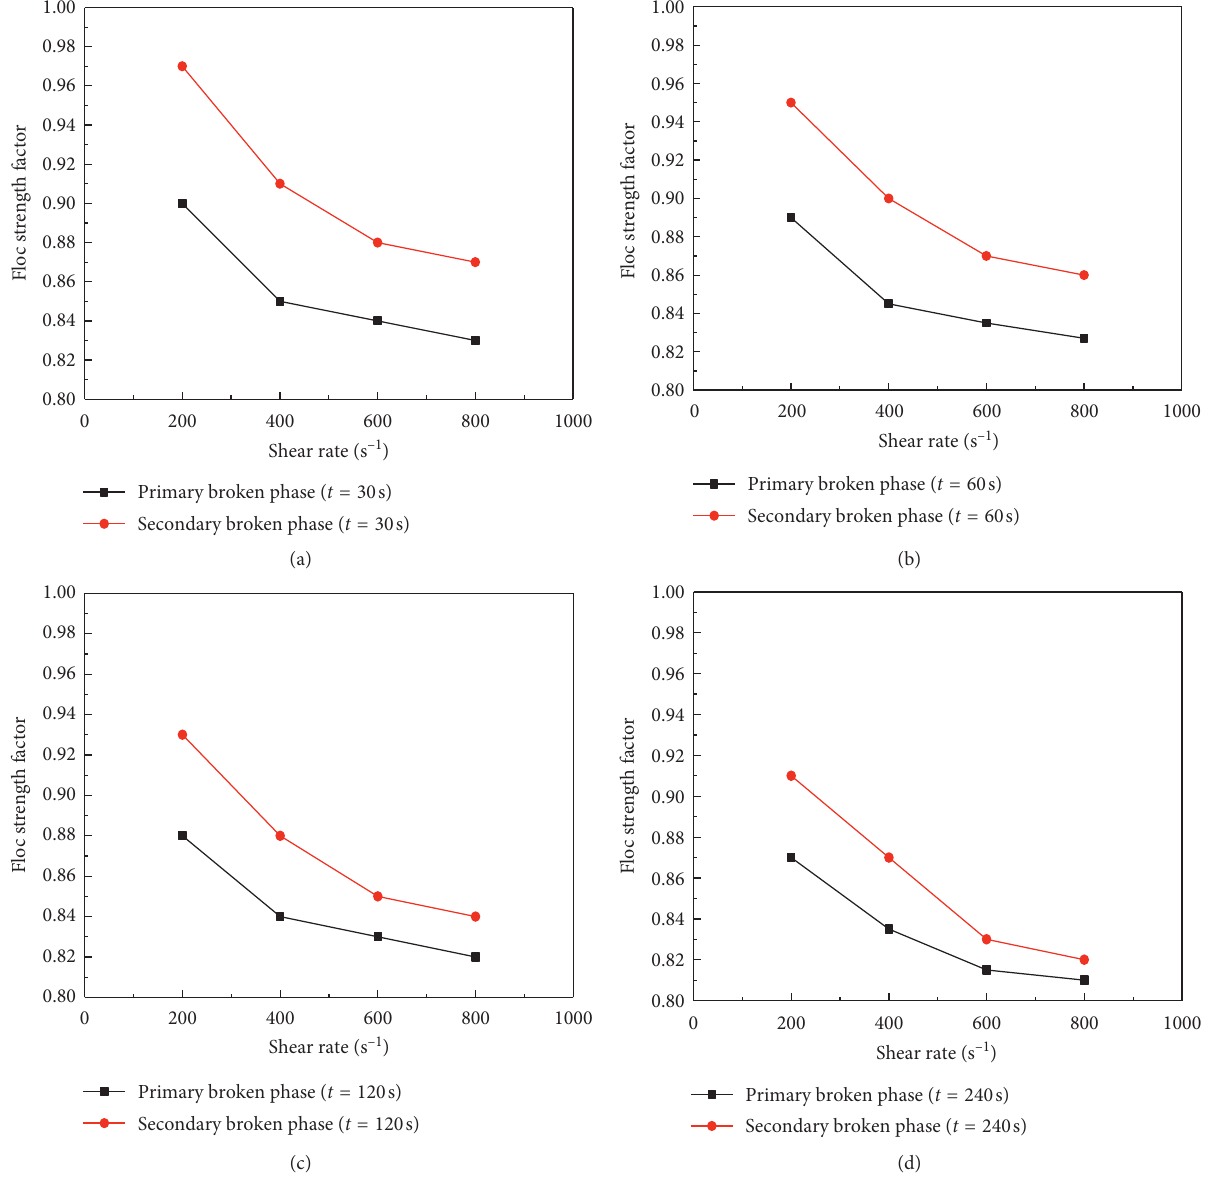
Figure 9: The variation of floc strength factor with shear rate during different shear times in the primary broken and secondary broken